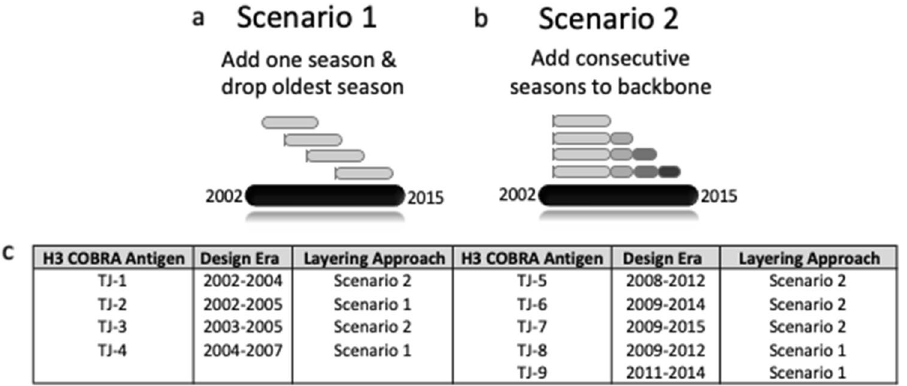
Figure 1. Next-generation H3 COBRA HA multi-consensus sequence layering approach scenarios and final antigen designs. Secondary layer consensus sequences derived from influenza isolates spanning a 2.5 year period are used to generate a “backbone” consensus sequence (light grey bar). ( a ) Scenario 1. Secondary consensus sequences produced from the most recent 6-months of A(H3N2) influenza circulation are added into the backbone sequences, and secondary sequences from the oldest 6-month season of the 3-year period are dropped off. This process is repeated for each 6-month period of the design era. ( b ) Scenario 2. Secondary sequences produced from the most recent 6-months of influenza circulation are added to the “backbone” sequence and the oldest sequences from the design era are retained. This process is repeated for each 6-month period of the design era. ( c ) Description of the next-generation COBRA H3 HA vaccine antigens, their design eras, and the scenario used to generate them. TJ1–4 were designed utilizing wild-type influenza virus HA sequences from 2002 to 2007, and TJ5–9 were generated from HA input sequences that were in circulation from 2008 to